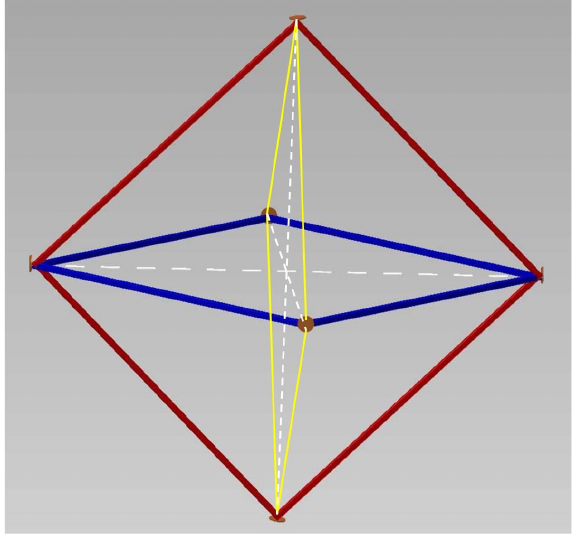
Figure 1. A possible configuration of Gyroscopes In General Relativity (GINGER): an octahedron. Six mirrors give rise to three mutually perpendicular square